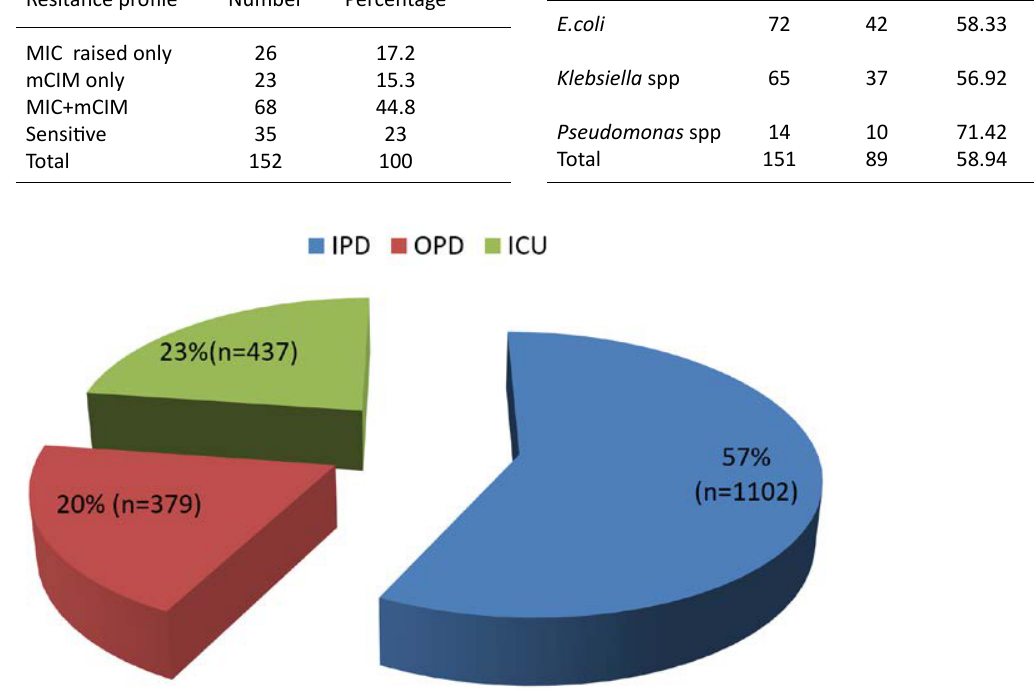
Chart 1. Distribution of samples location